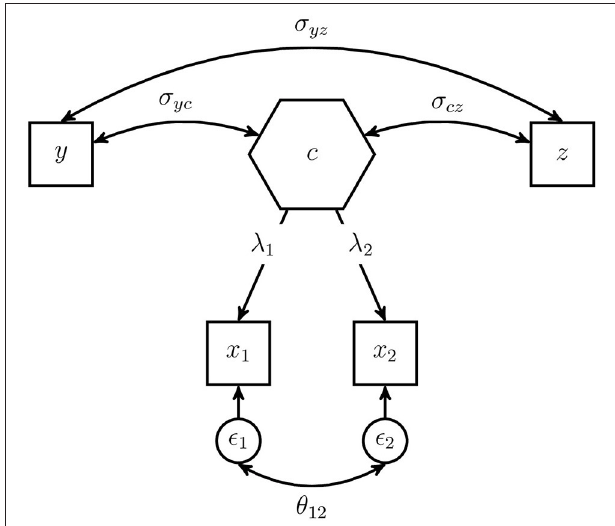
FIGURE 3 | Example of a composite model displayed as composite factor